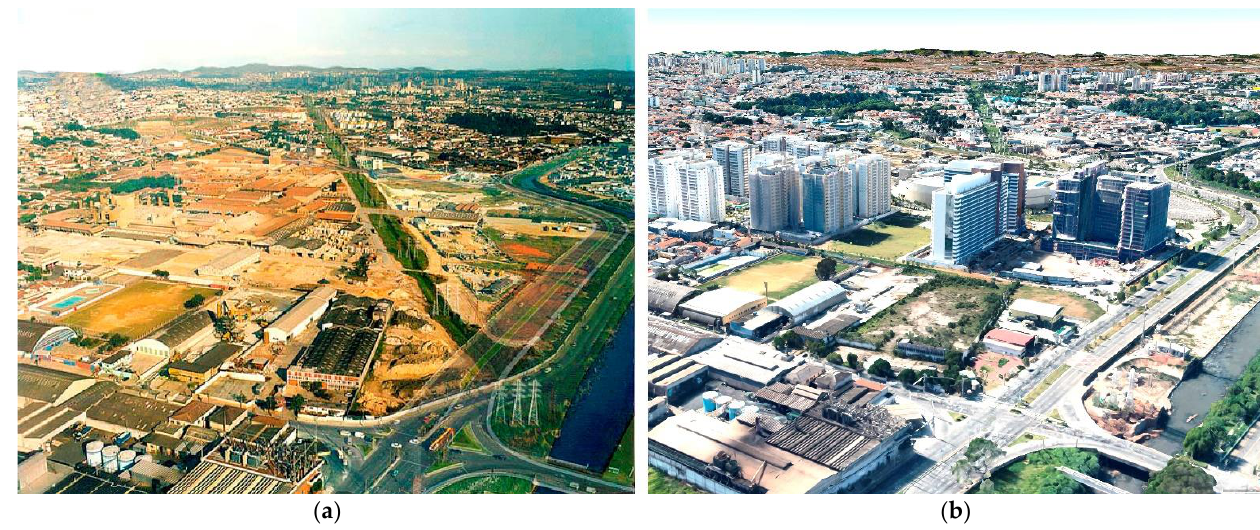
Figure 16. ( a ) Aerial photo of the former ceramic industry site in 1998, with the intersecting power transmission line, ( b ) aerial view of this site nowadays, with the residential and office towers and the rounded mall building in the back. The relocated transmission line contours the site. Sources: [42,61].